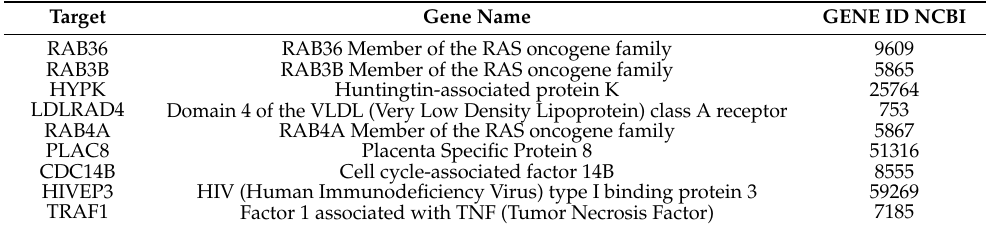
Table 11. Targets of miR